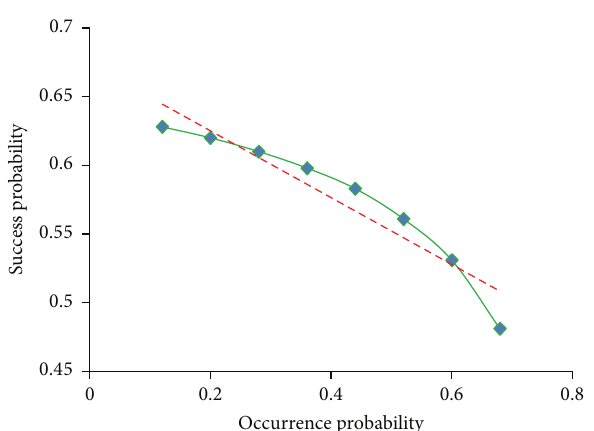
Figure 8: Impact of variation probability of loop occurrence on suc- cess probability.